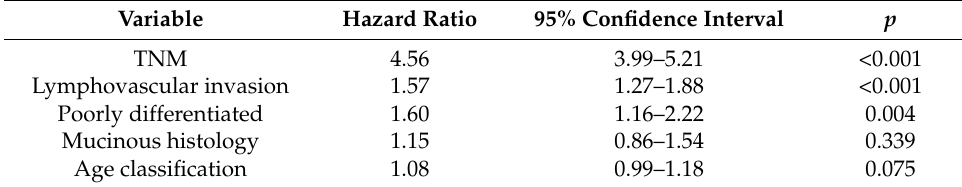
Table 3. Multivariate analysis for cancer specific survival.